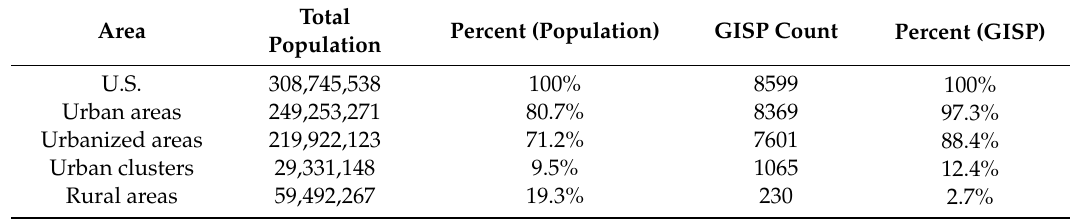
Table 3. The numbers of GISPs in urban and rural